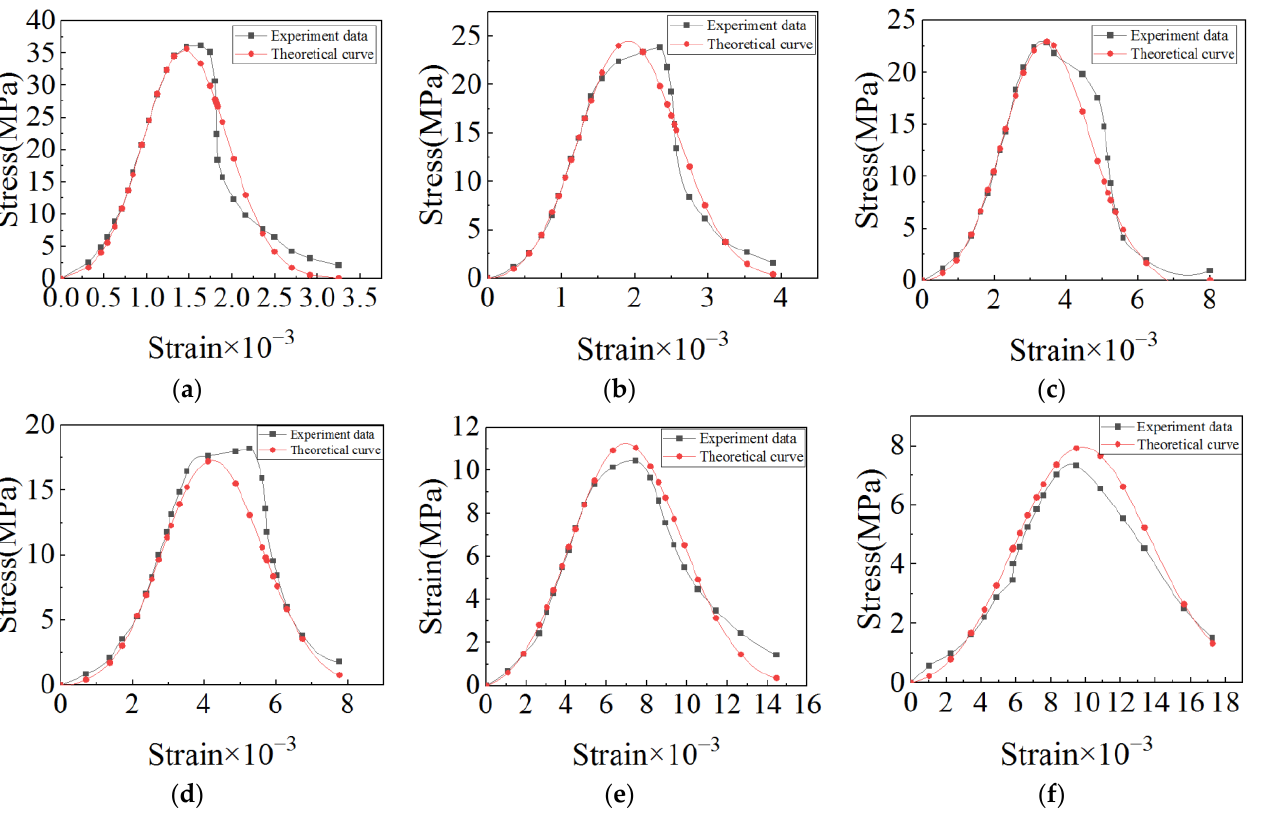
Figure 7. Comparison of test data and theoretical data: ( a ) 20 °C; ( b ) 100 °C; ( c ) 200 °C; ( d ) 400 °C; ( e ) 600 °C; ( f ) 800 °C.